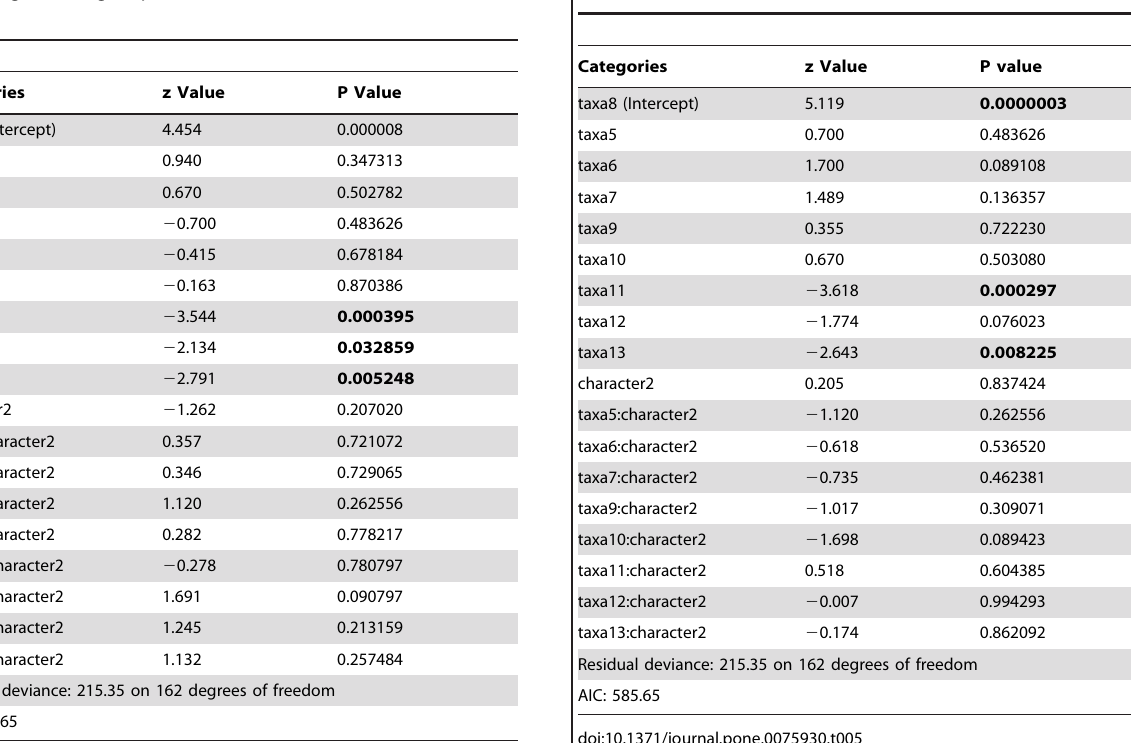
Table 5. Generalised Linear Model with all the pairwise comparisons between taxa8 and the other eight taxa groups and their interactions with character sets.